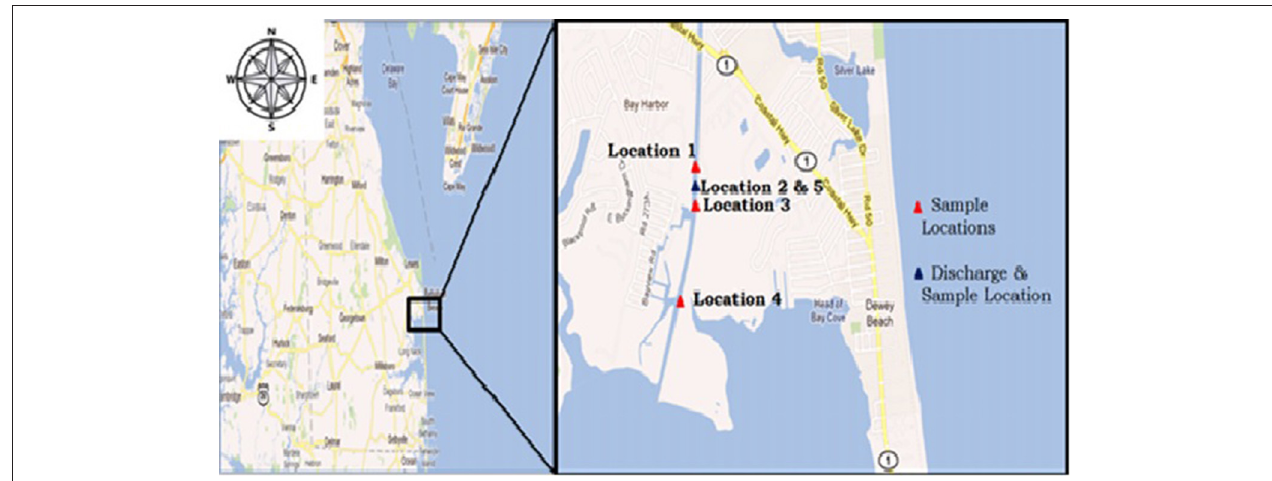
FIGURE 2 | Study locations on the map. Location 5 is separate because this location is the effluent pipe at the wastewater plant. Location 2 is where Location 5 discharge waters are received into the tidal canal ( Cannon et al., in press).